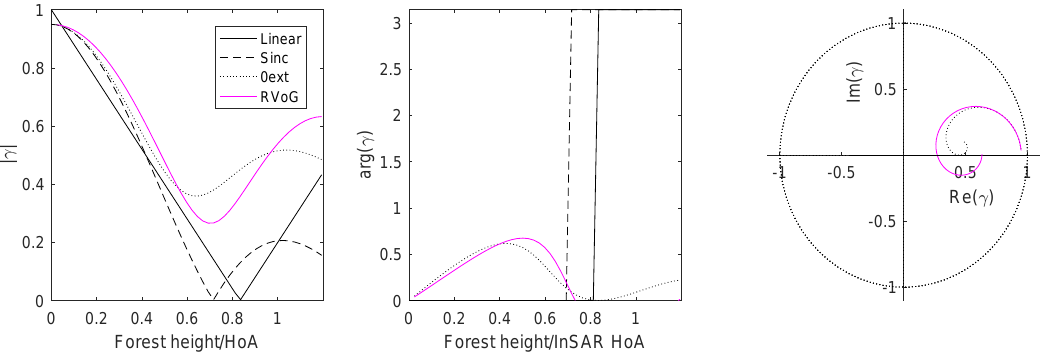
Figure 1. Proposed semi-empirical models for modeling InSAR coherence as a function of stand height (black lines) along with the RVoG model (magenta line). The amplitude of the coherence is on the left; the phase is presented in the middle; and the complex plane on the right. On the x-axis is forest stand height over the Height of Ambiguity